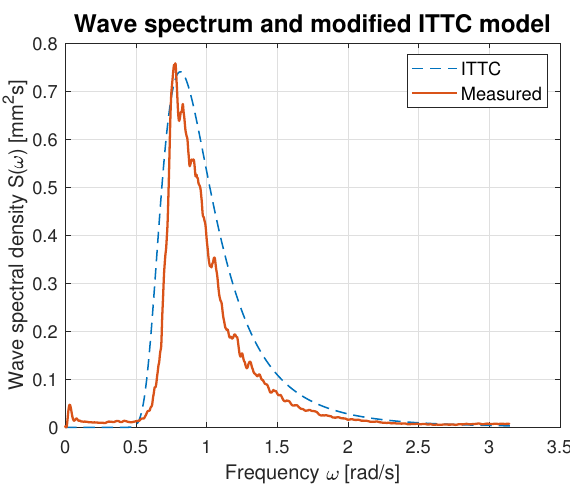
Figure 18. Comparison of the empirical wave spectrum evaluated for 6 BFT wind force in ship scale and the modified ITTC model.